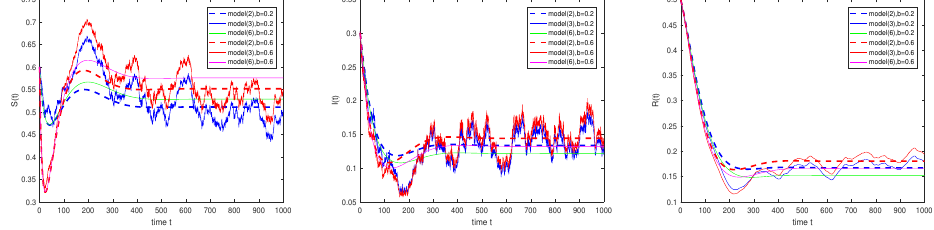
Figure 3. The paths of S ( t ) , I ( t ) , and R ( t ) under the birth rate b = 0.6,0.2. Example 3. Take b = 0.3 , r = 0.25 , K = 0.9 , η = 0.5 , µ = 0.05 , φ = 0.2 , κ = 0.09 , and